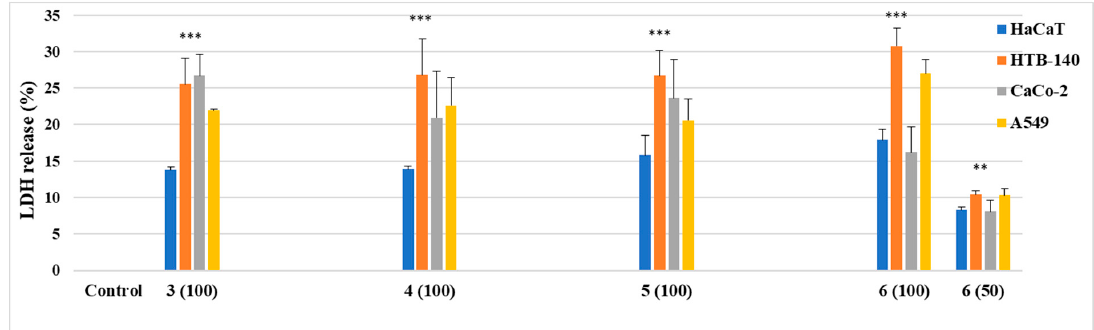
Figure 6. LDH release as a marker of a cell death in the HaCaT, HTB-140, CaCo-2, A549 cells, treated for 72 h with various concentrations of derivatives 3–6 (100 μ M for compounds 3–5 , 100 and 50 μ M for 6 ). Data are expressed as the mean ± SD from three independent experiments, performed in triplicate. *** p ≤ 0.001, ** p ≤ 0.01, as compared to the control. The LDH release from normal keratinocytes ranged from 13.8% (compound 3 ) to 17.9%